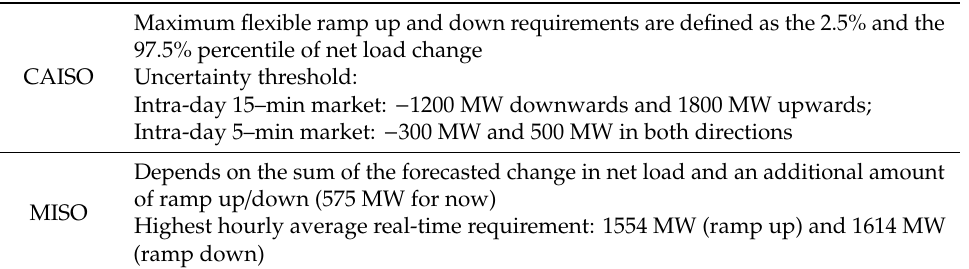
Table 1. Ramping reserve requirements